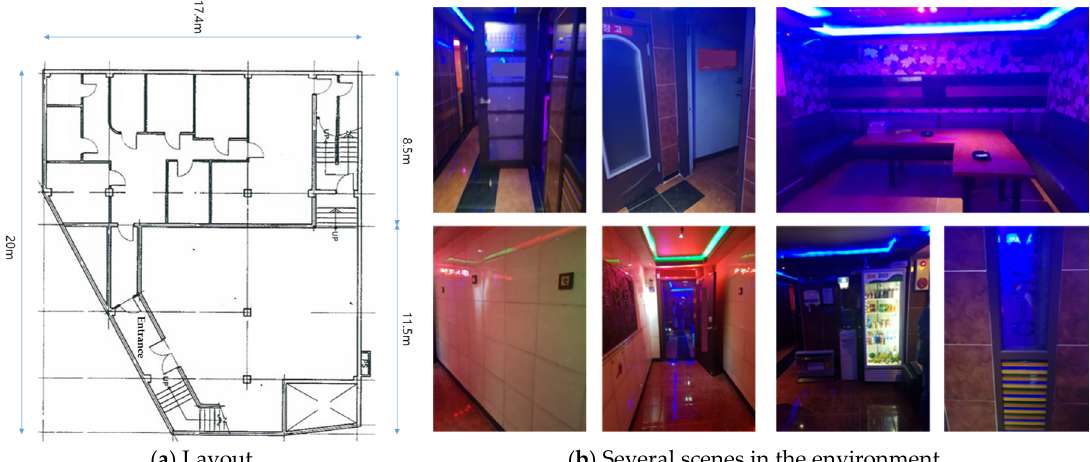
Figure 14. Indoor environment for the experiments.